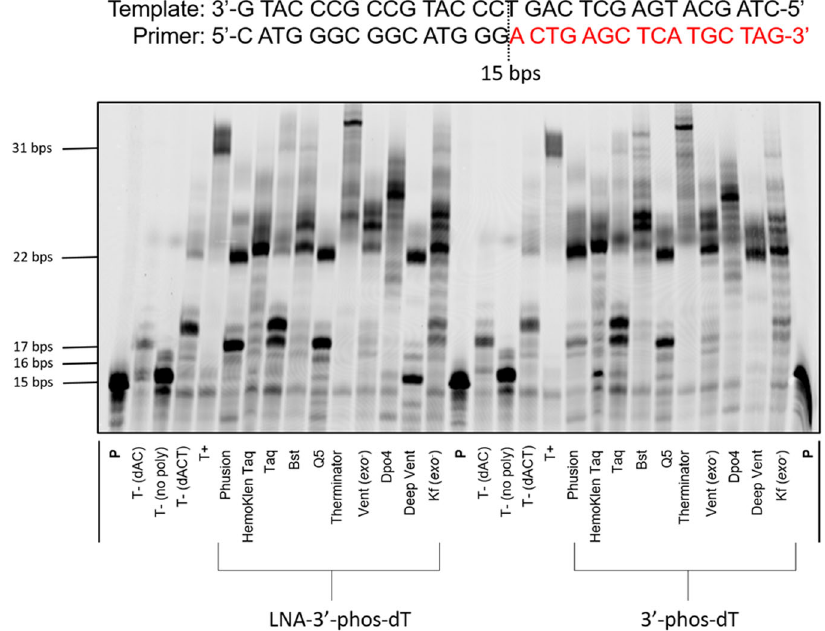
Fig. 3 Evaluation of modi fi ed nucleotides 5 and 10 under PEX reaction conditions. Gel image (PAGE 20%) shows the results of PEX reactions with 3 ′ - phos-dTTP 5 and 3 ’ -phos-LNA-TTP 10 with 5 ′ -FAM-labeled primer P1 (devoid of a 3 ′ -phosphate moiety), template T1 , and various DNA polymerases. Natural and modi fi ed triphosphates were at a fi nal concentration of 200 µ M. The following quantities of polymerases were used: Phusion (2 U), Hemo Klen Taq (8 reactions), Taq (5 U), Bst (8 U), Q5 (2 U), Therminator (2 U), Vent ( exo − ) (2 U): 60 °C, 1 h; Dpo4 (2 U), Deep Vent (2 U): 55 °C, 1 h; Kf ( exo − ) (5 U): 37 °C, 1 h. Negative control (T − ): No polymerase added to the mixtures or reactions with only dATP and dCTP or dATP, dCTP, and dTTP only. Positive